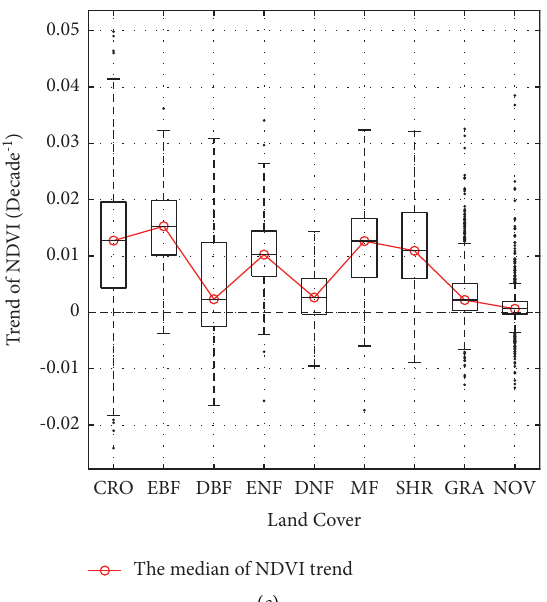
Figure 2: Spatial distribution of change in the annual NDVI (a) in China. The average change in NDVI for each subregion (b) (NEC: Northeast China, IM: Inner Mongolia, NWC :Northwest China, NC:North China, CC :Central China, SEC: Southeast China, SC :South China, SWC: Southwest China, and TP:Tibetan Plateau) and vegetation type (c) (DBF: deciduous broad-leaved forests, DNF: deciduous needleleaf forests, EBF: evergreen broad-leaved forests, CRO: croplands, SHR: shrublands, ENF: evergreen needleleaf forests, MF: mixed forests, and GRA grasslands).